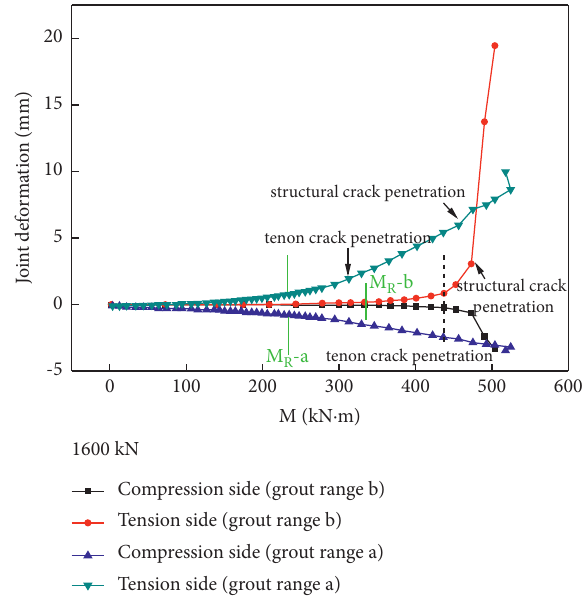
Figure 8: Development law of joint deformation with different grouting ranges (long single-tenon